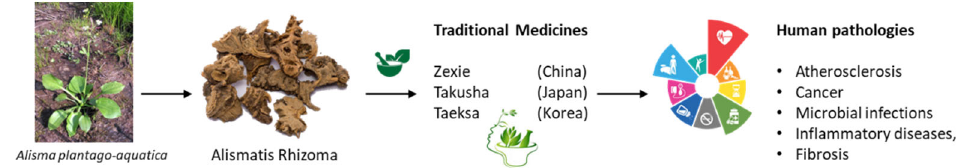
Figure 1. Medicinal uses of Alismatis rhizoma. The dried rhizomes of the plant Alisma plantago- aquatica are used to prepare the traditional medicinal products in Asian countries and the medicine is used to treat different pathologies, as